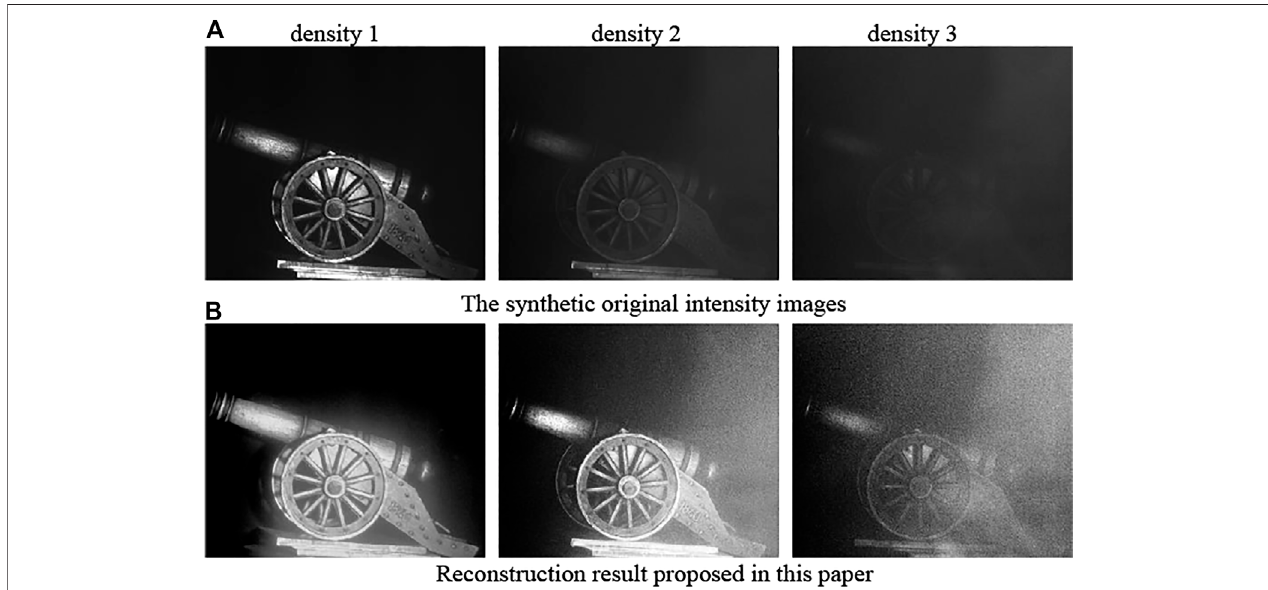
FIGURE 13 | Figure processing under the condition of different density of medium without bubble. (A) The synthetic original intensity images. (B) Reconstruction result proposed in this paper.